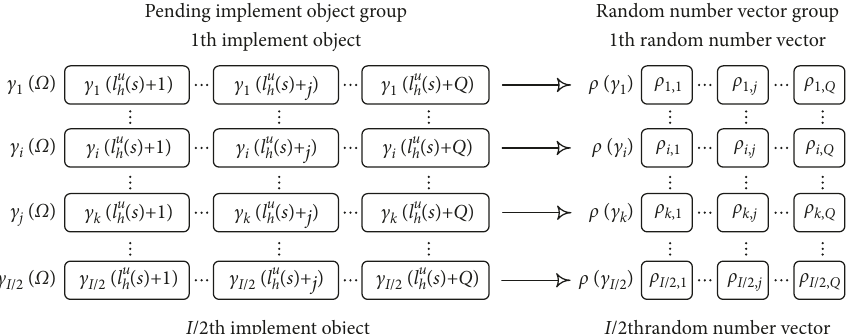
Figure 5: Pending implement object group and random number vector group.